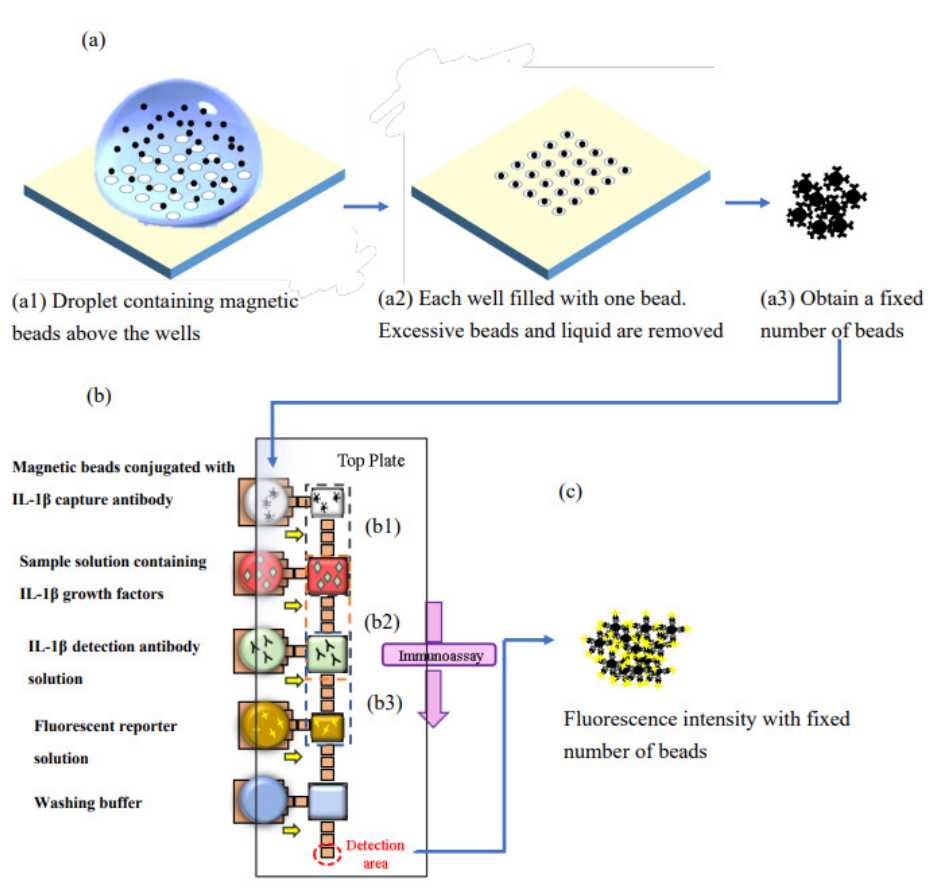
Figure 1. Operating concept: ( a ) obtaining the specified magnetic bead number on a bead screening chip; ( b ) immunoassay process on the chip with a fixed number of magnetic beads; ( c ) beads’ aggregation for fluorescence intensity measurement at the detection area.